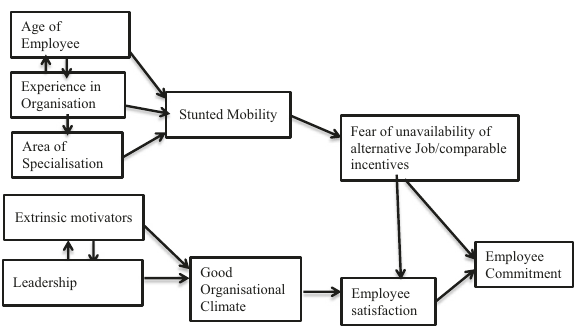
Fig. 1 A model of factors that motivate employee commitment in organisations. Source: Author ’ s conceptual framework of the study